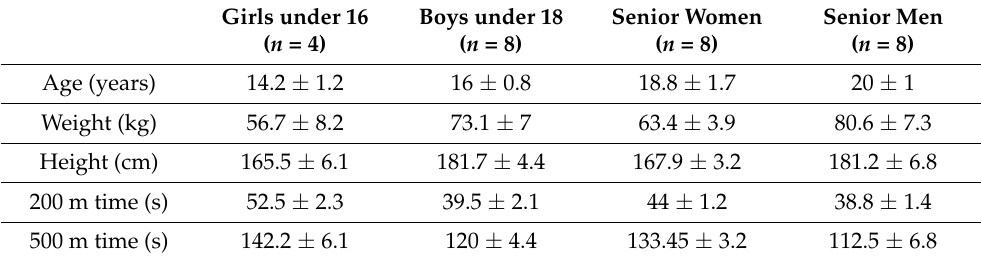
Table 1. Participant characteristics ( n = 28).